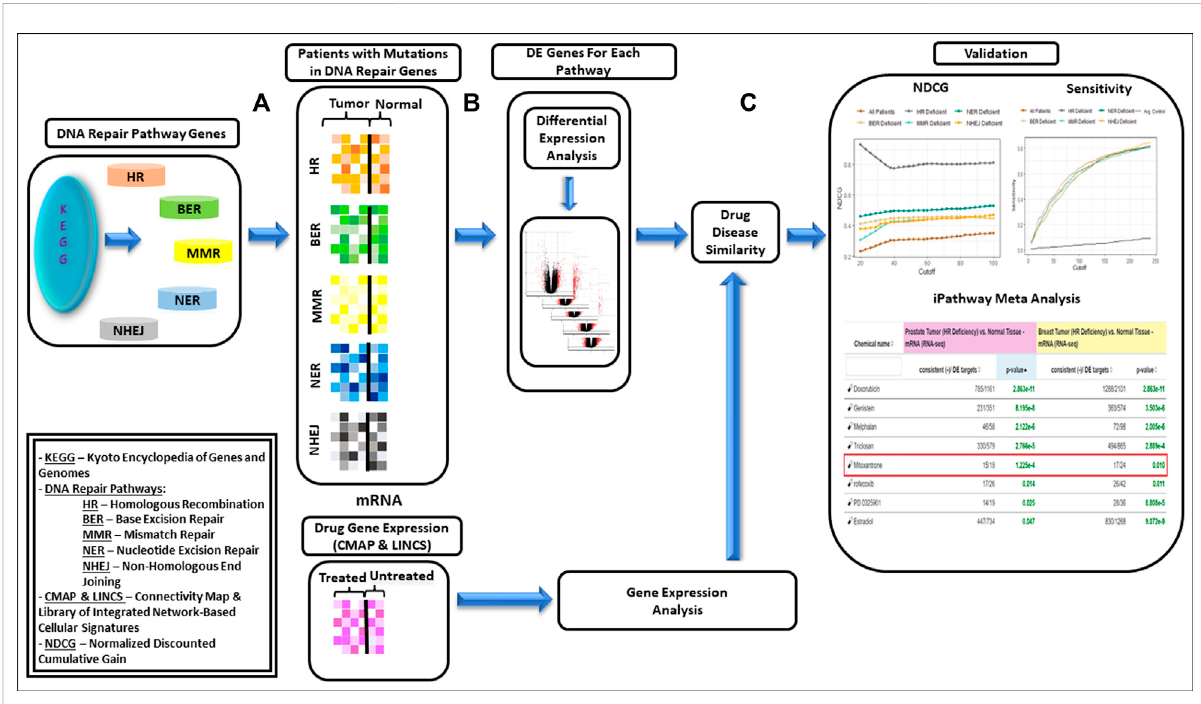
FIGURE 2 Framework proposed for data-driven drug repurposing for biologically similar cancers — (A) : Genes within each of the DNA repair pathways, i.e., HR (Homologous Recombination), BER (Base Excision Repair), MMR (Mismatch Repair, NER(Nucleotide Excision Repair) and NHEJ (Non- Homologous End Joining) were identi fi ed using KEGG database. Subset of breast and prostate cancer patients with mutations in DNA repair genes were identi fi ed and grouped based on DNA repair de fi ciency. (B) : Differentially expressed genes (DEGs) were identi fi ed on each cohort separately. (C) : Drugs for each cohort were identi fi ed using Drug-Disease Similarity. Framework was validatedusing NDCG (Normalized Discounted Cumulative Gain) and sensitivity scores; and network interaction analysis was used for validating the utility of the